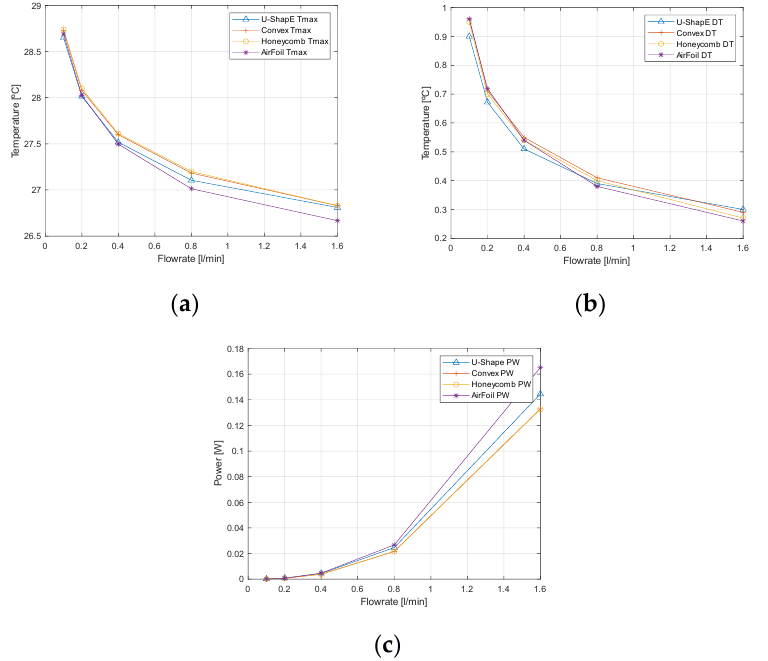
Figure 7. Geometry comparison results of ( a ) battery cell maximum temperature ( T max ), ( b ) temperature homogeneity (Δ T ), and ( c ) the pumping power consumption related to the auxiliary system ( P h ) at different flow rate.